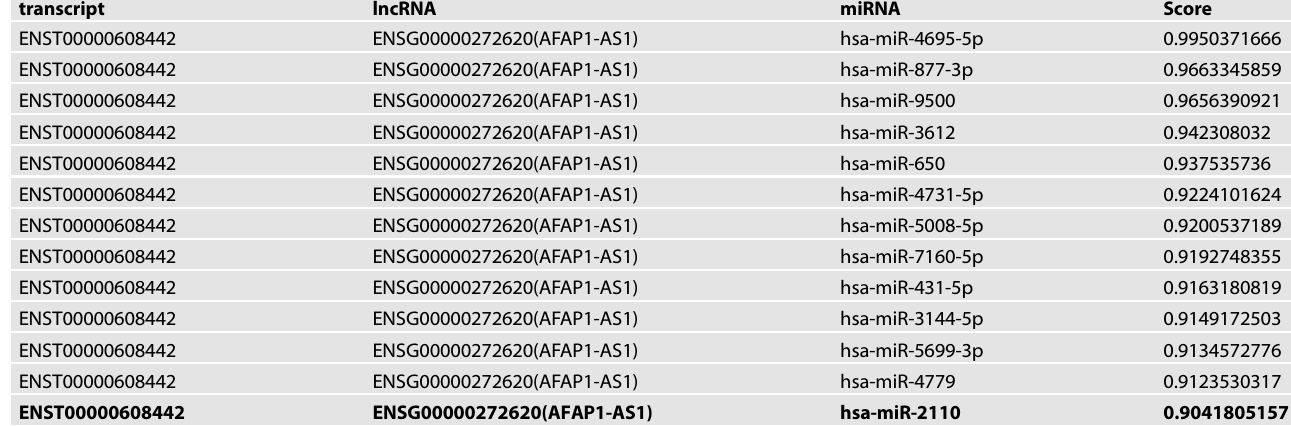
Table 1. Search for miRNAs that could have potential interactions with AFAP1-AS1 (ENSG00000272620) via LncBase database.